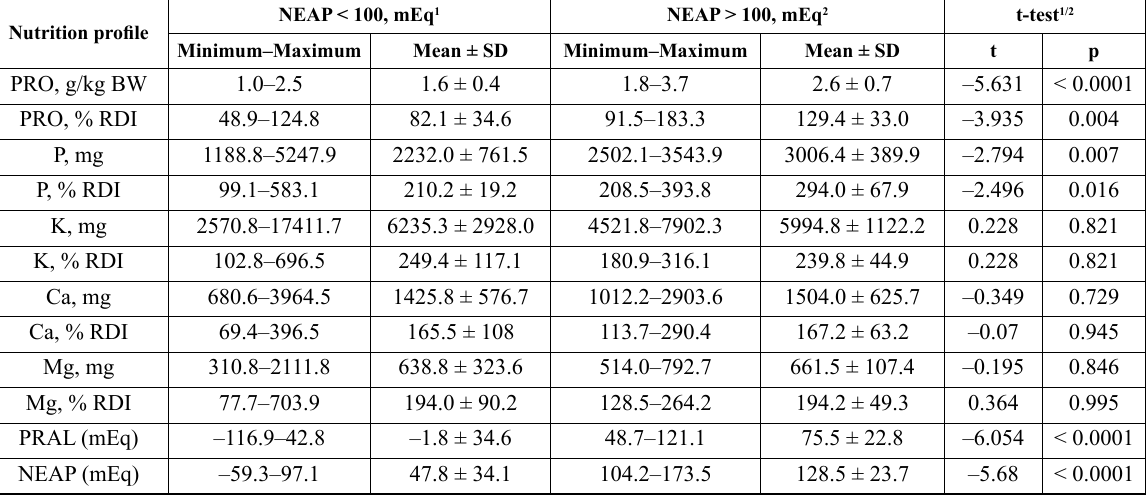
Table 3. Daily intakes of protein and selected micronutrients and estimated potential renal acid load (PRAL) in Lithuanian Olympic team basketball players (by the net endogenous acid production (NEAP) groups) Nutrition